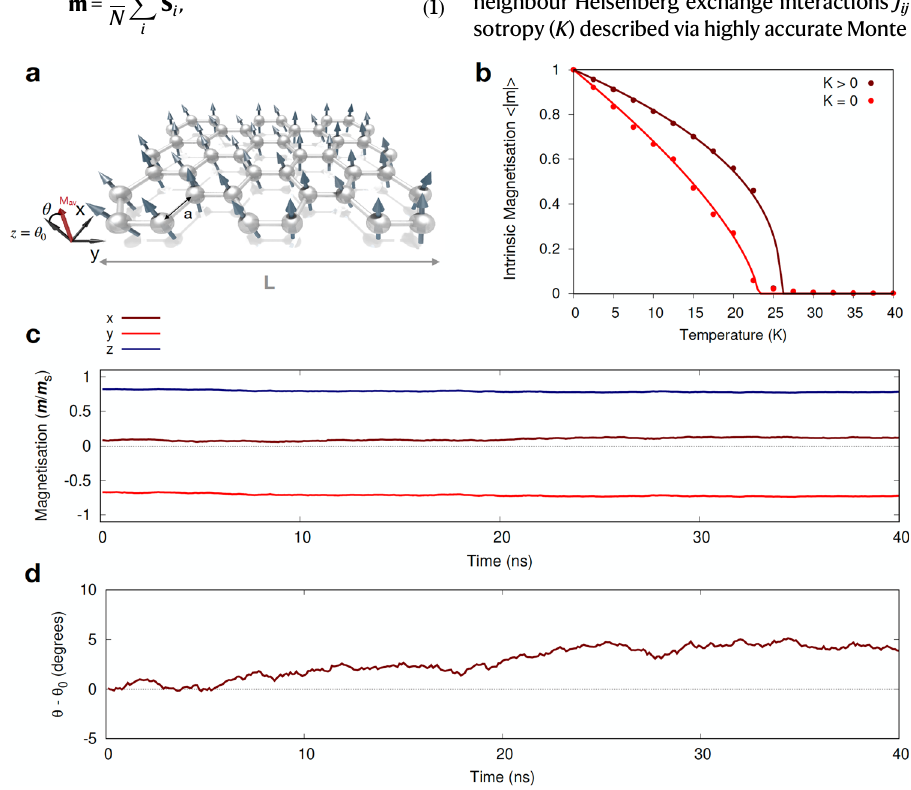
Fig. 1 | Short-range magnetic ordering at fi nite temperatures in a 2D isotropic magnetisation 〈 ∣ m ∣ 〉 with ( K =1×10 − 24 J/atom) and without ( K =0) anisotropy in a magnet.a Localviewofthespindirectionsextractedfromtheatomisticsimulations 1000×1000 nm 2 fl ake. Solid lines are the fi t to Eq. (3). For K =0, the fi tting para- metersare β =0.54±0.020and T x =23.342±0.237K.For K >0, β =0.427±0.021and on a 2D honeycomb lattice. a is the atomic spacing ( a =0.4 nm), L is the length considered in the computations, and M av is the averaged magnetisation vector. T x =26.543±0.320K. c , d Temporalvariationofthemagnetisation( m / m s )andangle θ θ corresponds to the angle between M θ − θ av and the z -axis. 0 =0 denotes the initial 0 ,respectively,at T =10K.Allthreespatialcomponents( x , y , z )areconsideredin c . The dashed line in d shows the initial state in the con fi guration aligned with the z -axis. b Temperature-dependent intrinsic